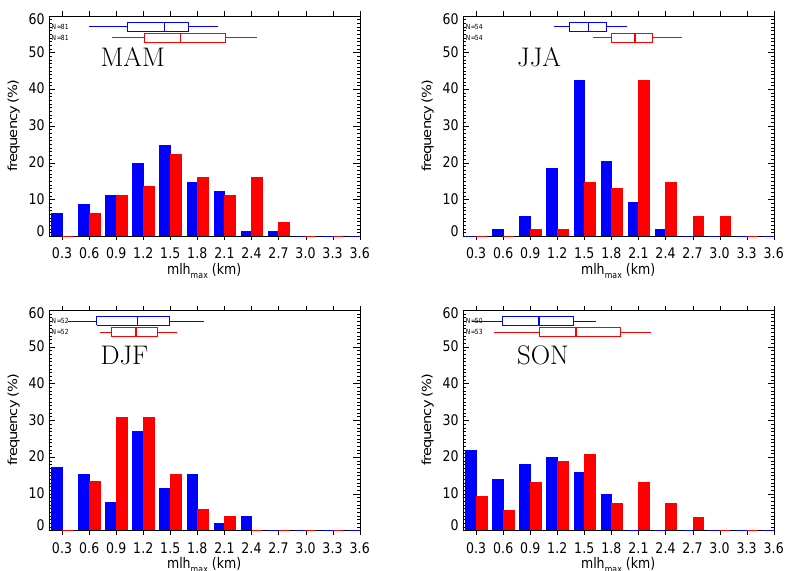
Figure 8. Frequency of occurrence of maximum MLH from wind lidar (blue) and ceilometer (red) for spring, summer, autumn and winter (clockwise from top left). Whisker boxes on top show 10, 25, 75 and 90% percentiles and the